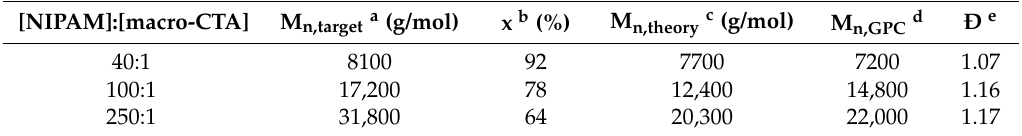
Table 2. Data for the RAFT-mediated polymerization of N -isopropylacrylamide (NIPAM) at 65 °C in dioxane.